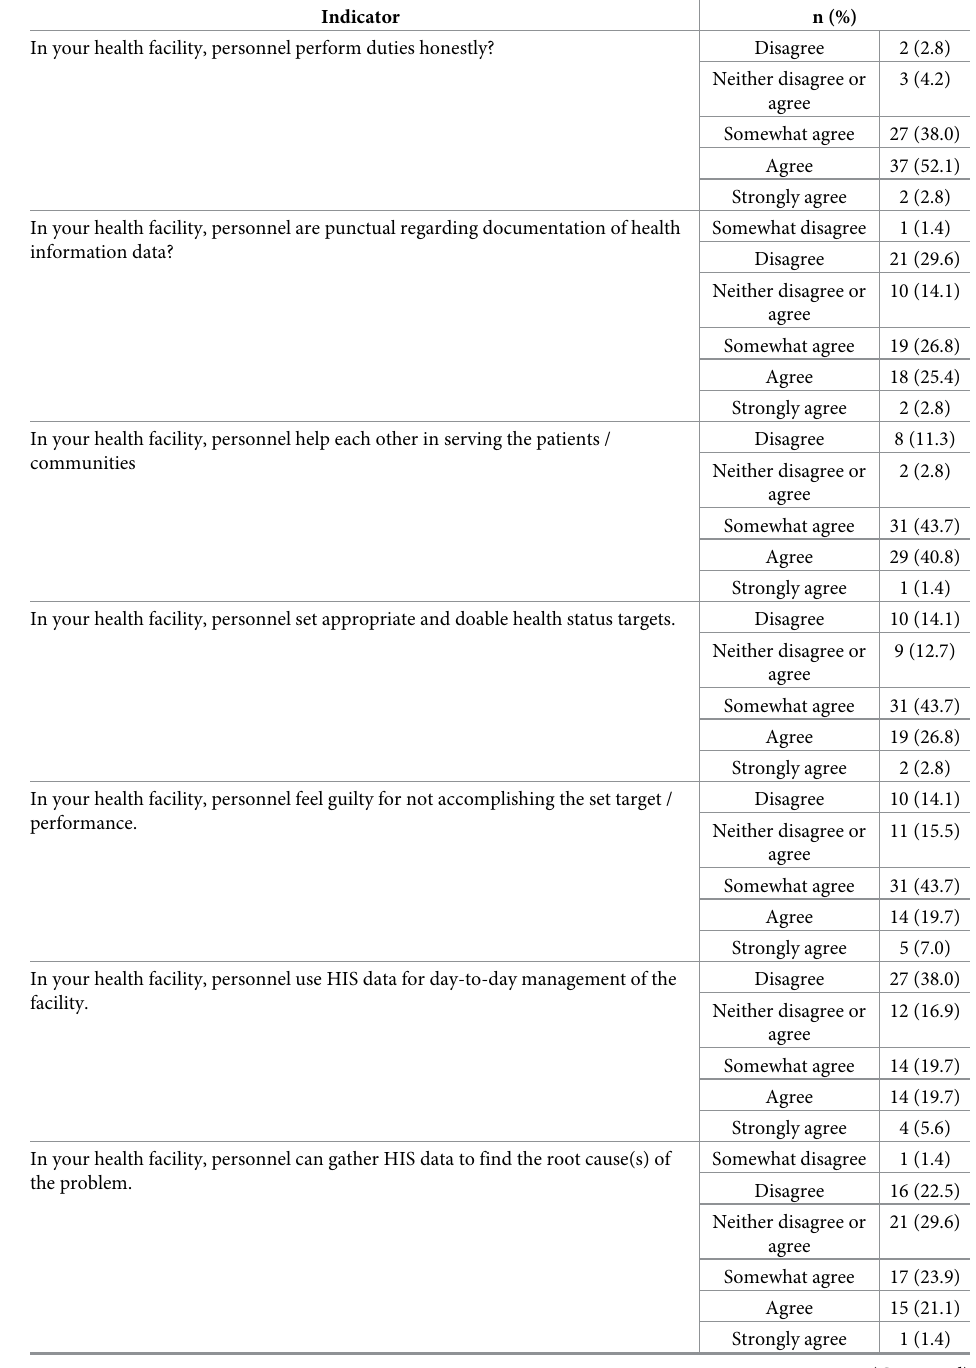
Table 6. Personnel capacity regarding management of health information